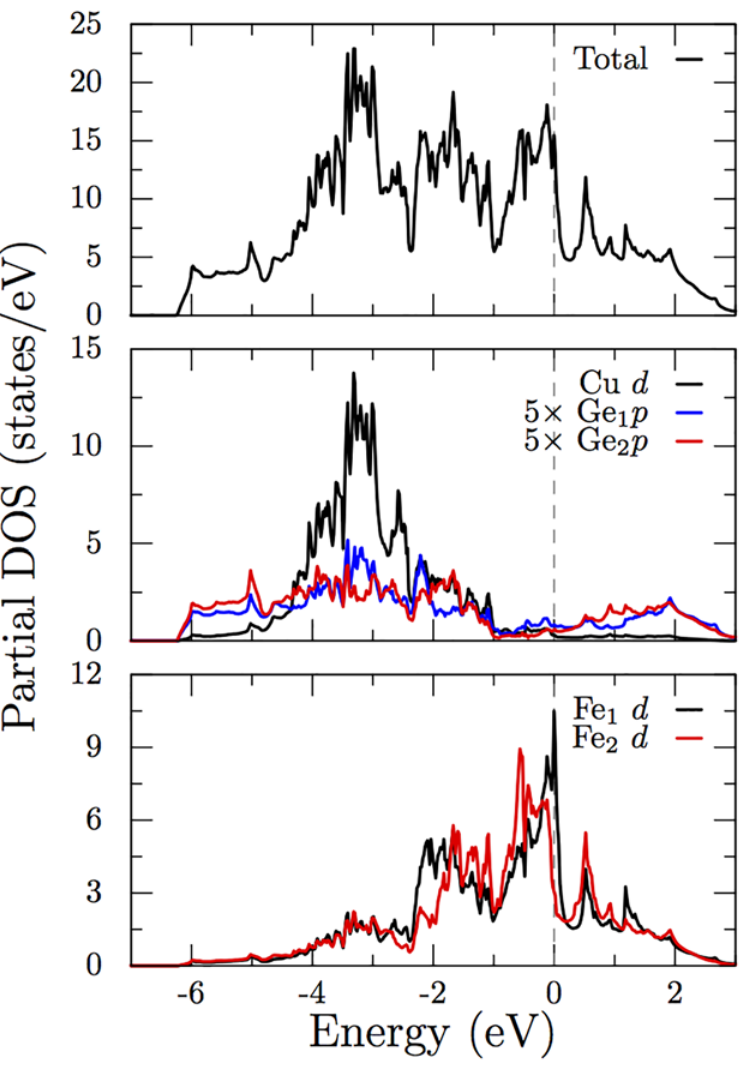
Fig 4. Total and partial density of states (DOS) for the non-magnetic calculation. Cu- d states are below the fermi level while Fe- d and Ge- p are partially occupied. Not shown are Fe and Cu s states, that are empty.